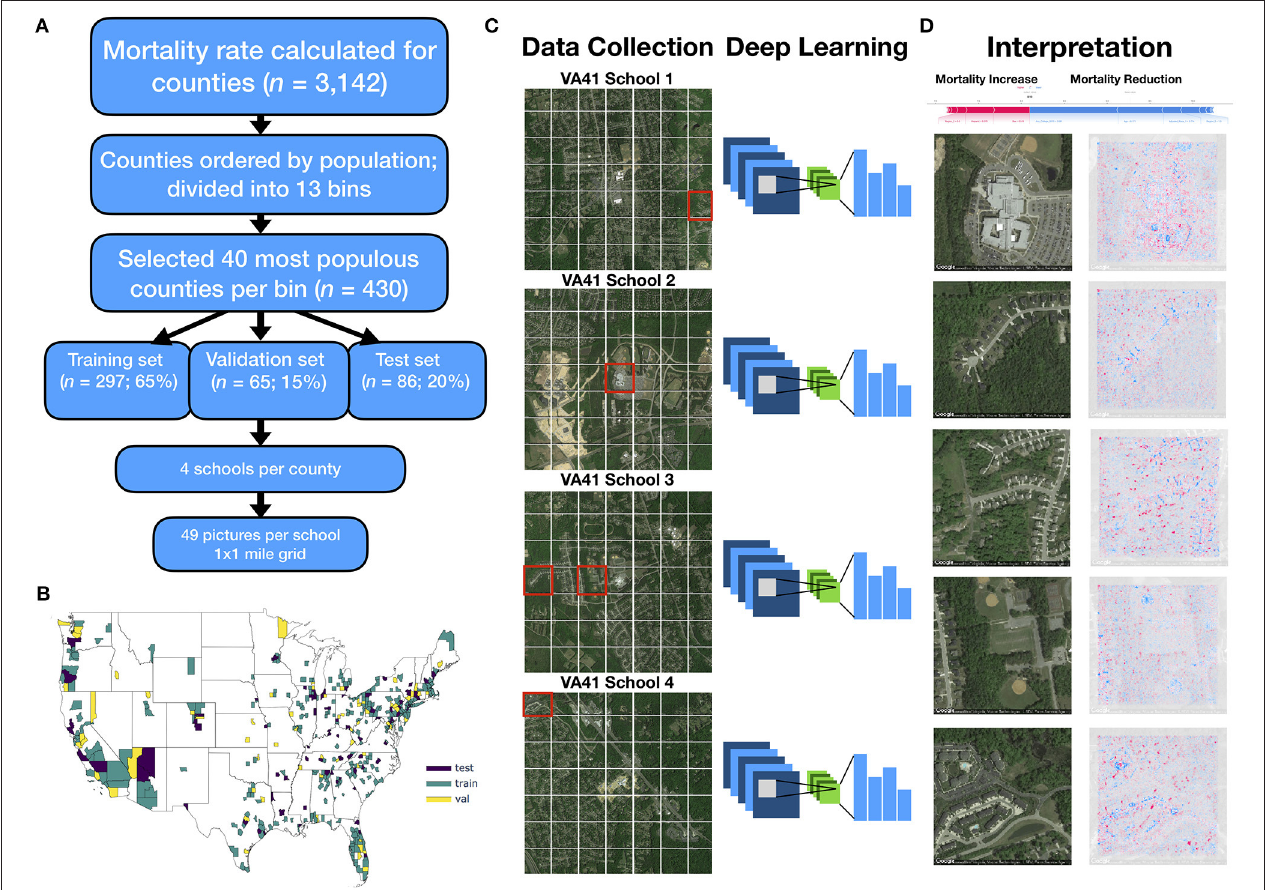
FIGURE 1 | Method overview: (A) flow diagram depicting selection of counties and sampling scheme for images; 13 mortality bins created from 1,000 most populous counties to capture diversity of mortality rates; (B) map of the United States colored by selection of training, testing and validation counties; (C) 4 sets of 1 × 1mile grid of images (7 images by 7 images) were selected per each county, all images randomized and used to train deep learning model; visual depiction of deep learning: filters slide across each image and pick up on key image features, pooling layers reduce spatial dimensions of image, and output layers of neural network output one mortality rate prediction per image, ˆ y i ; histogram visualization to the right of the neural network represents the set of mortality rate predictions {ˆ y i | i ∈ { 1,2, ... , 195,196 }} corresponding to 196 images per county (49 images per school * 4 schools per county), which are averaged across using a trimmed mean to yield final mortality rates ( ˆ y county = P ˆ y i ); (D) SHAP is applied to neural network model and image to generate a heatmap of important image features across each image (red, N positively associated with mortality; blue, negatively associated with mortality); these visualizations are compared to important covariates from linear model for each test county (visualized as force plot placed above the heatmap images; where presence of colors red/blue indicates positive/negative associations with